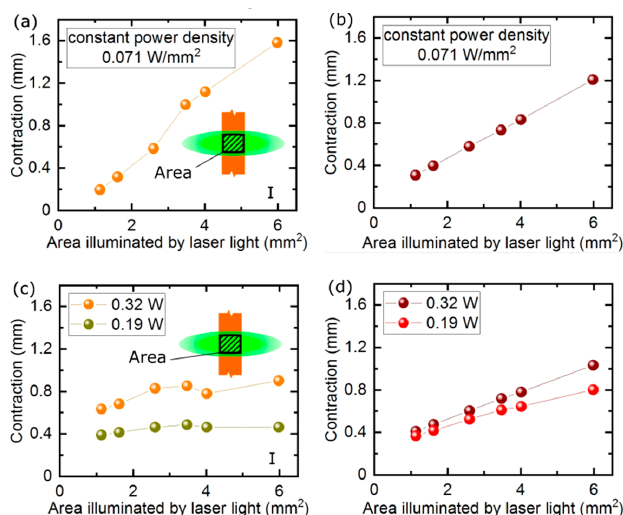
Figure 4. Linear actuator response with different spatial distribution of the light energy in the laser beam. Measured ( a ) and simulated ( b ) actuator response upon illumination with laser beams of increasing size and constant power density. Measured ( c ) and simulated ( d ) actuator response upon illumination with laser beams of constant power and varying size.